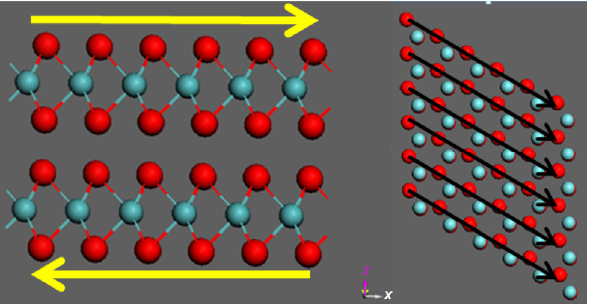
Schematic showing the relative sliding between two single layer MoO 2 (6 × 6 × 1) nanostructures; arrows show the sliding directions. The red spheres represent the oxygen atoms and the light blue spheres represent the transition metal